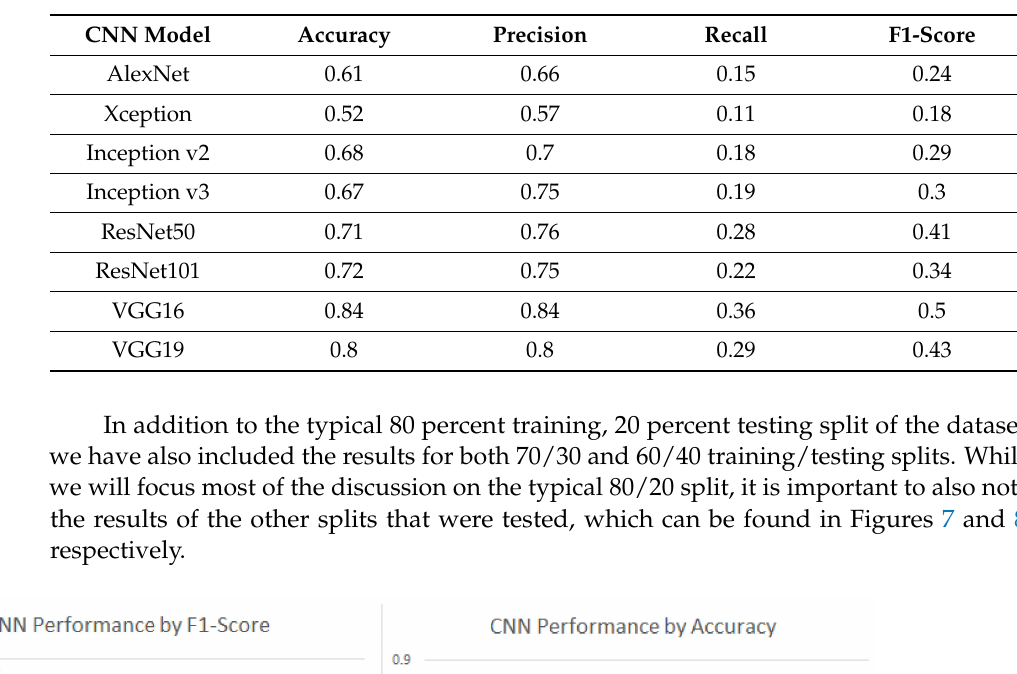
Figure 6. Results of CNN Image Classification testing by ( a ) F1-Score and ( b ) Accuracy, 80/20 Split. Table 4. Further analysis of Classification Report for our tested CNNs, 80/20 Split.